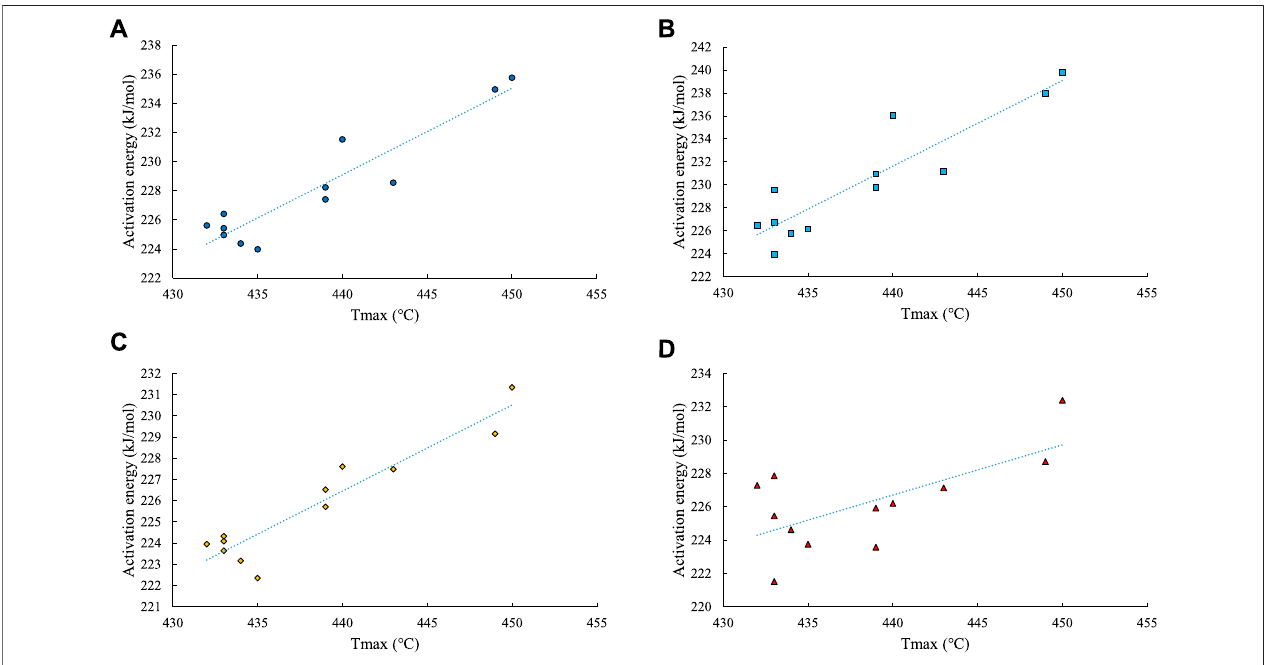
FIGURE12| Therelationshipbetweentheactivationenergyofhydrocarbongenerationintheopensystemand Tmax. (A) totalhydrocarbonsfromorganicmatter. (B) generation of C 1 – 5 from organic matter. (C) generation of C 6 – 14 from organic matter. (D) generation of C 14+ from organic matter.